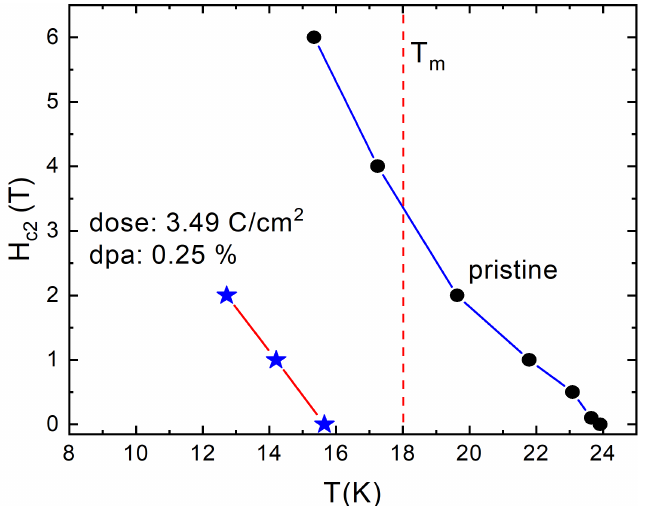
Figure 7. Upper critical field, H c 2 ( T ) , of pristine (black circles) and 3.49 C/cm 2 electron irradiated (blue stars) EuFe 2 ( As 0.77 P 0.23 ) 2 with the magnetic field applied along the c -axis. Note that the slope, dH c 2 ( T ) / dT near T c in irradiated state is larger than the slope in the pristine